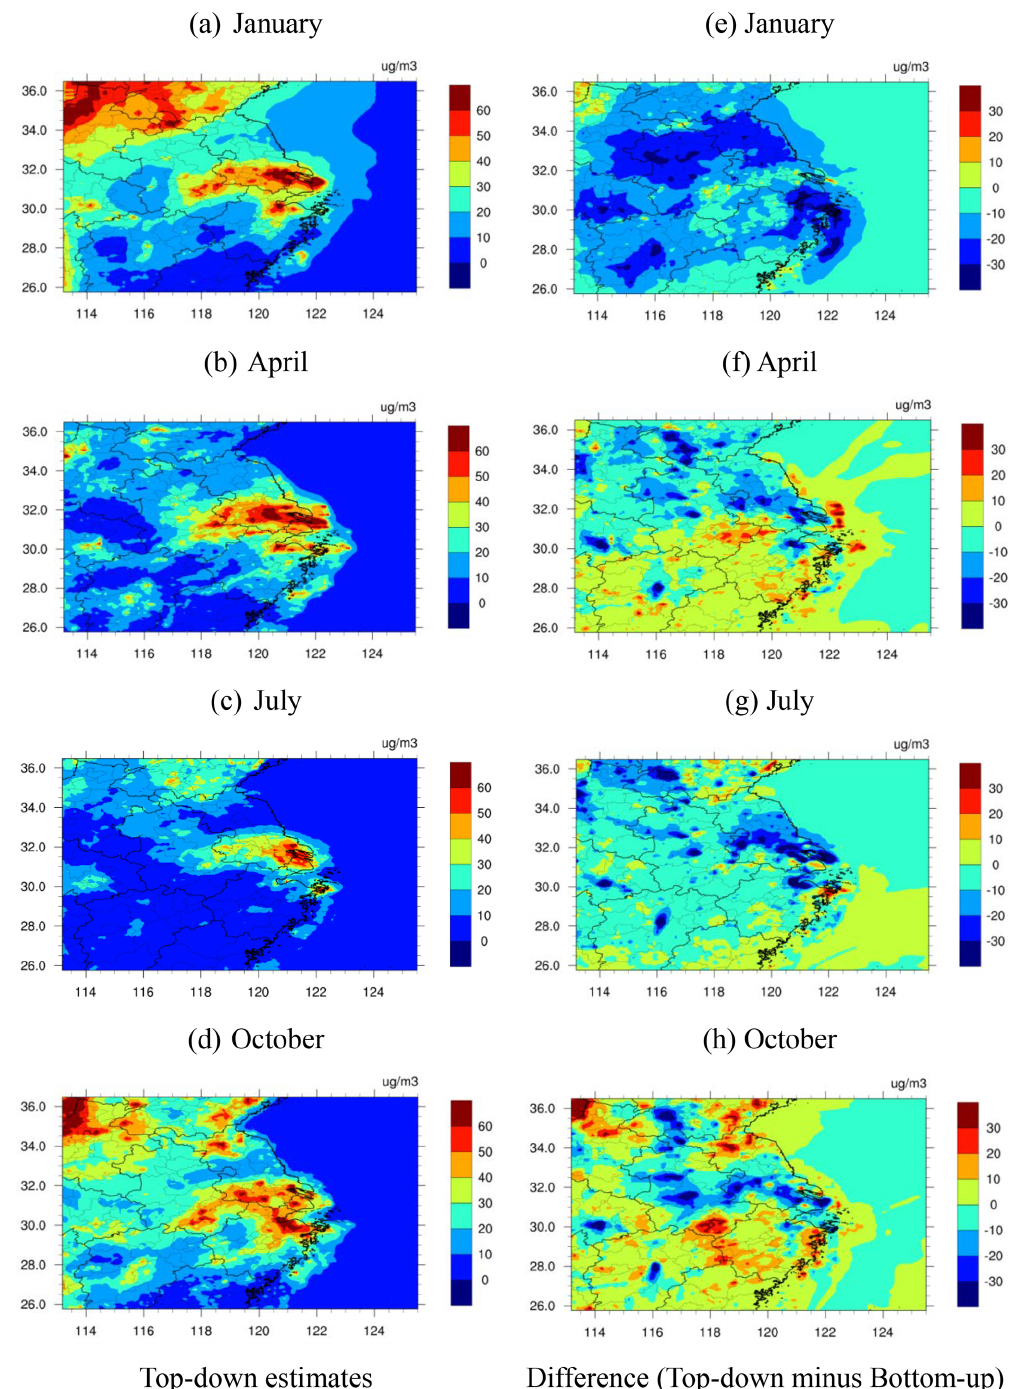
Figure 5. The spatial distribution of the simulated monthly mean NO 2 concentration with the top-down estimates and differences between the simulations with the top-down and bottom-up NO x emissions in January, April, July, and October 2016 (top-down minus